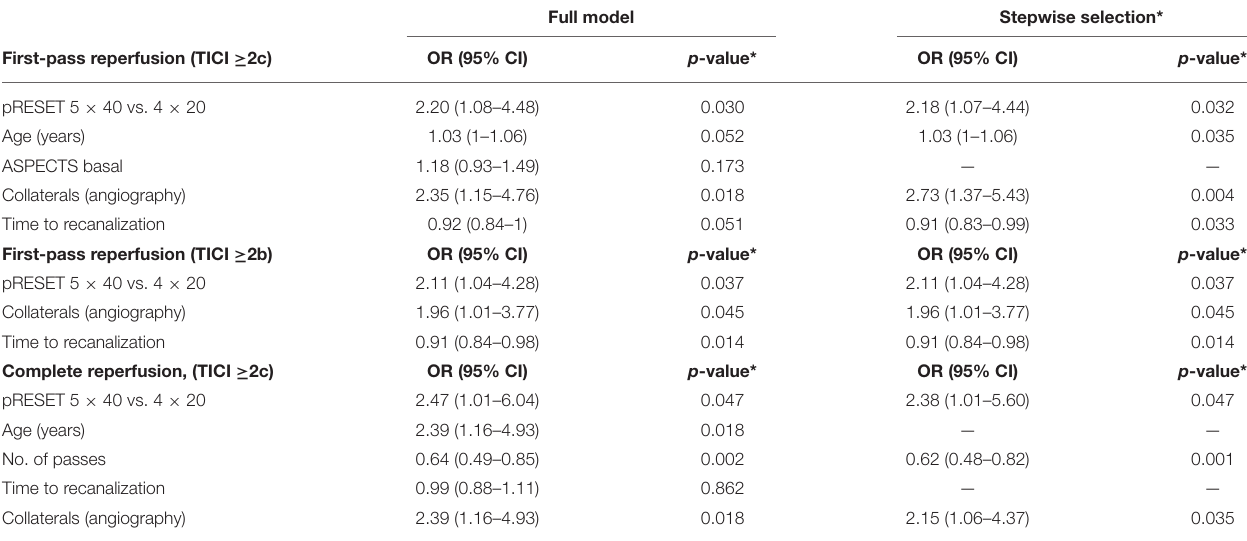
TABLE 3 | Preset 5 × 40 vs. pRESET 4 × 20 in M1-MCA occlusions: multivariate analysis.